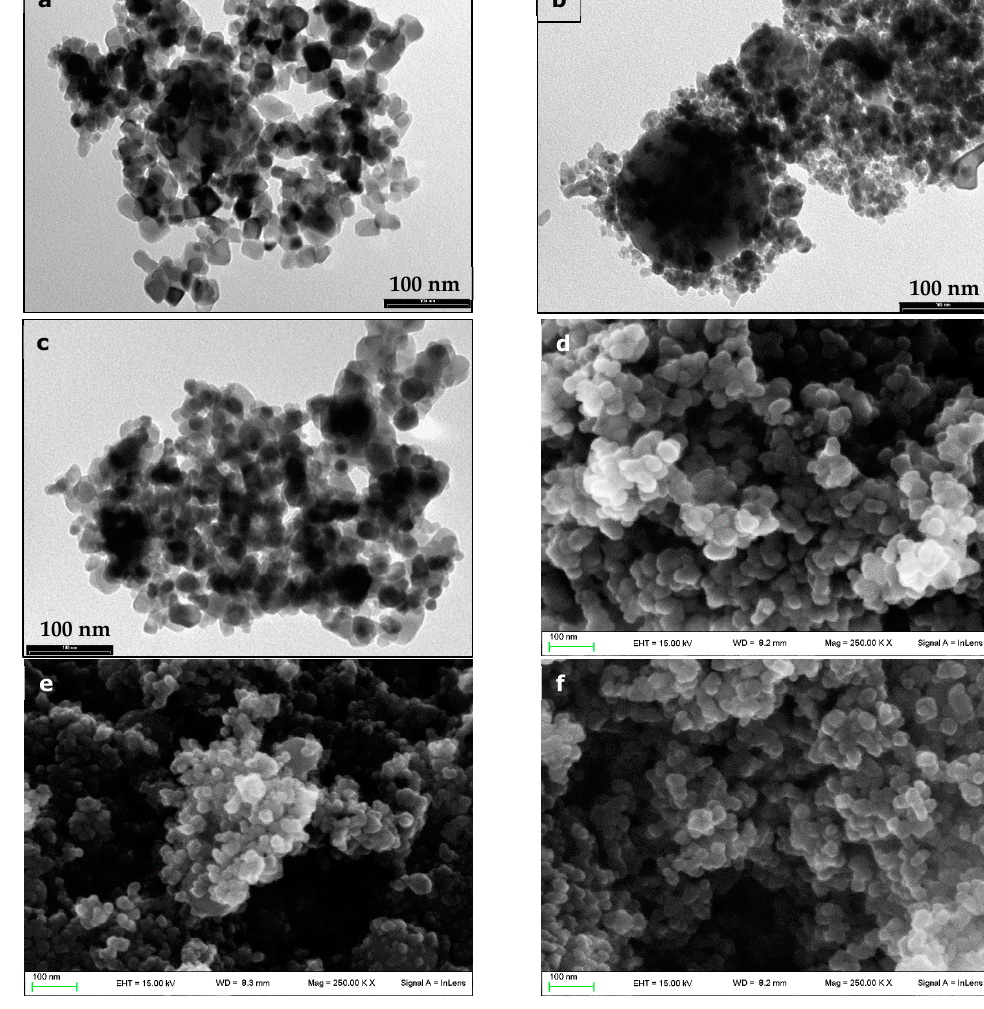
rected where necessary to take into account overlapping contributions, as suggested else-